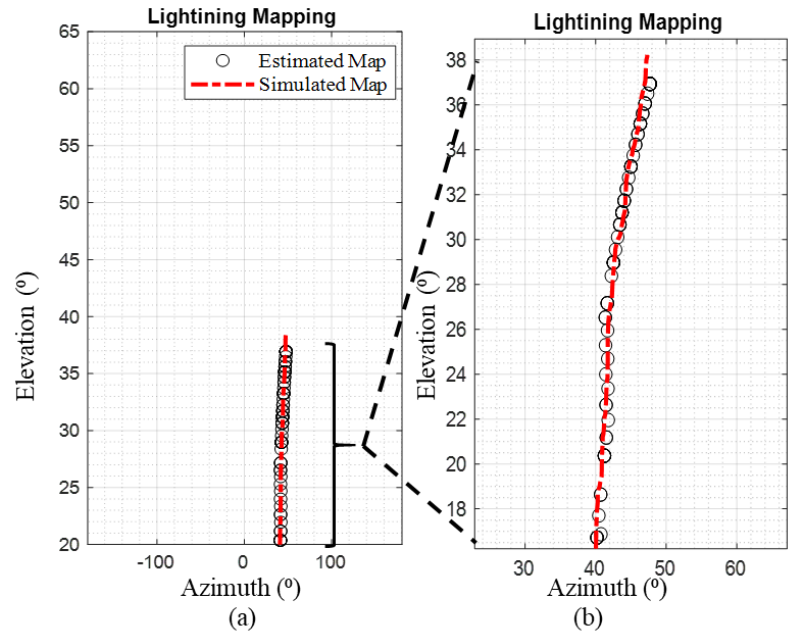
Figure 5. PSO algorithm: ( a ) simulated lightning map plotted in elevation vs. azimuth; ( b ) expanded view of the simulated lightning maps of ( a ).